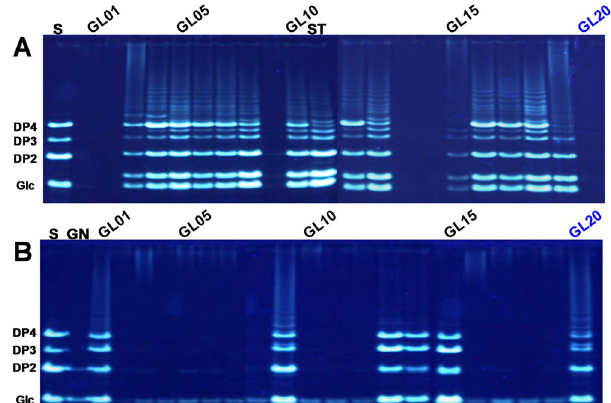
Figure 3. PACE fingerprints of α -amylase ( A ) and 1,3- β -D-glucanase ( B ) digested polysaccharides in G . lucidum dietary supplements. S , mixture of glucose ( Glc ), laminaribiose ( DP2 ), laminaritriose ( DP3 ), and laminaritetraose ( DP4 ); S1 , mixture of glucose ( Glc ), galactose ( Gal ), laminaribiose ( DP2 ), laminaritetraose ( DP4 ), and D-galacturonic acid ( GalA ); ST , enzymatic digestions of starch; GN, enzymatic digestions of β -1,3- glucan; The sample codes were the same as in Table 1.